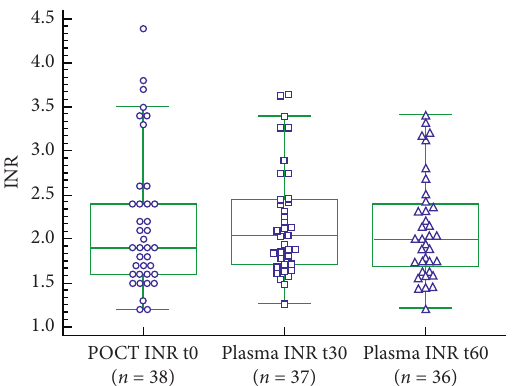
Figure 2: Box and Whisker plot POCT INR t 0 and plasma INR t 30 and t 60 Figure 3: POCTand plasma INR comparisons in Passing and Bablok regression ( n � 105). Regression equation: plasma INR � 0.46 (95% CI: Table 3: Agreement of POCT INR with plasma INR measure-